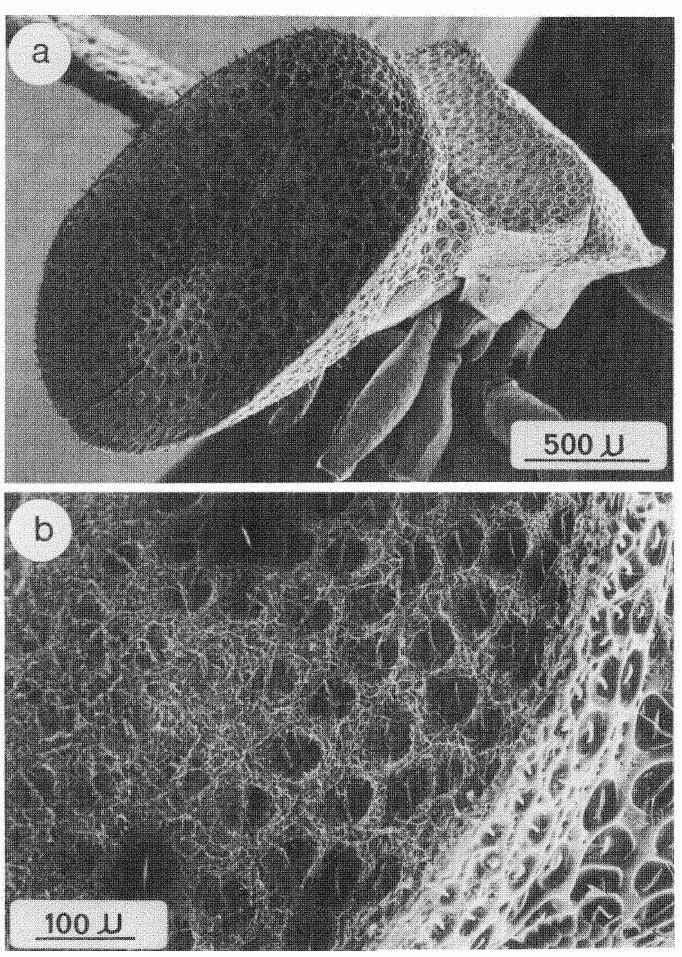
Fig. 2. Z. varians (Lignumvitae Key, FL). a. Soldier head covered with tangled mat of fibers, b. Mat of fibers is confined to the cephalic